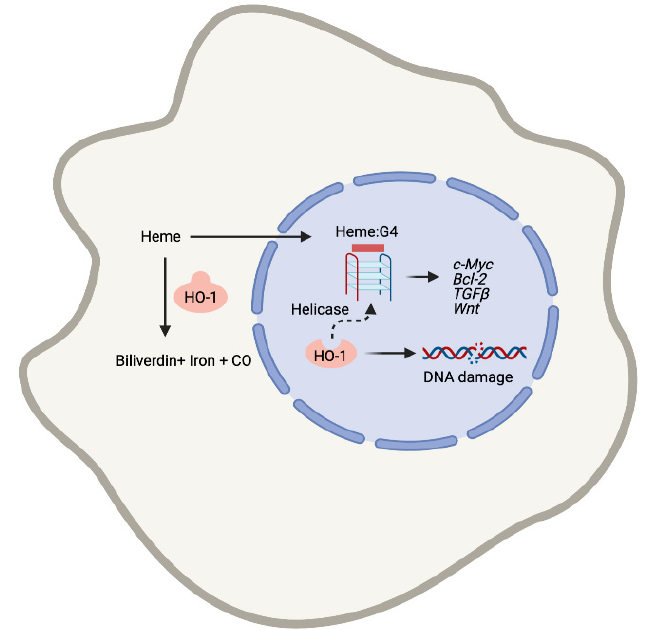
Figure 5. A scheme showing the role of nuclear heme in gene regulation of key genes (c -MYC, BCl-2, TGF β , Wnt ) as well as DNA damage signaling. An interaction of nuclear HO-1 with H2AX may be a site for recruiting factors (i.e., helicases) for repair and resolution of G4 structures, which are regulated by presence of nuclear heme.